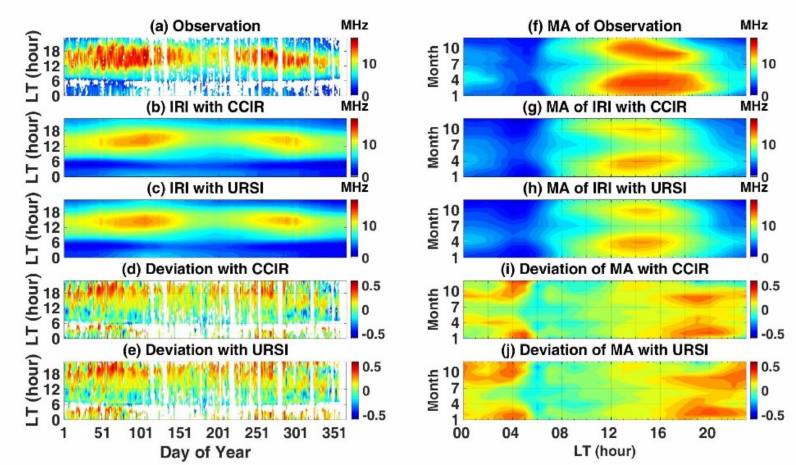
Figure 1. ( a ) the observed fo F2 ( b ) fo F2 calculated by the International Reference Ionosphere (IRI) with CCIR option ( c ) fo F2 calculated by IRI with International Union of Radio Science (URSI) option ( d ) the normalized deviation of the observed fo F2 to that derived by IRI with CCIR ( e ) the normalized deviation of the observed fo F2 to that derived by IRI with URSI ( f ) monthly average (MA) of the observed fo F2 ( g ) monthly average of fo F2 calculated by IRI with CCIR option ( h ) monthly average of fo F2 calculated by IRI with URSI option ( i ) normalized deviation of monthly average observation fo F2 to that derived by IRI with CCIR ( j ) normalized deviation of monthly average observation fo F2 to that derived by IRI with URSI.